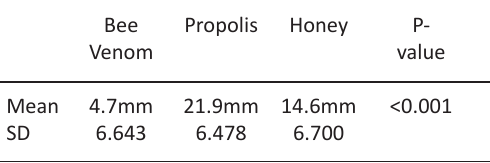
Table 3. Result of the Disc Diffusion method in millimeter (mm) of Bee Products against the studied